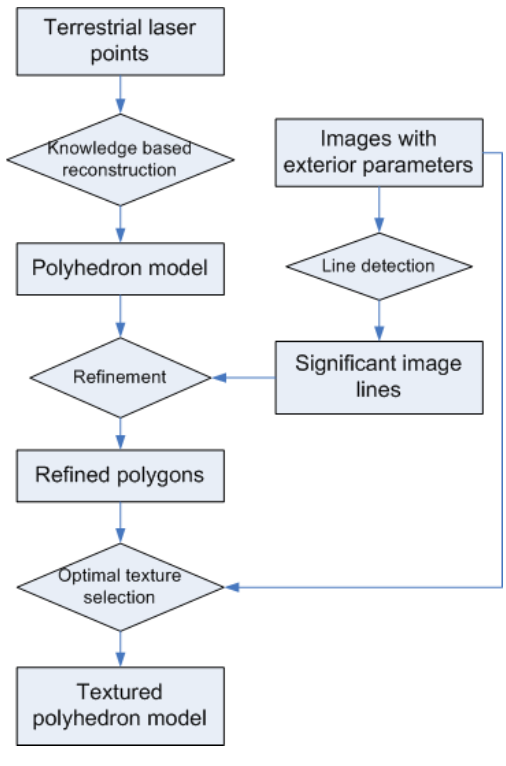
Figure 1. Building reconstruction